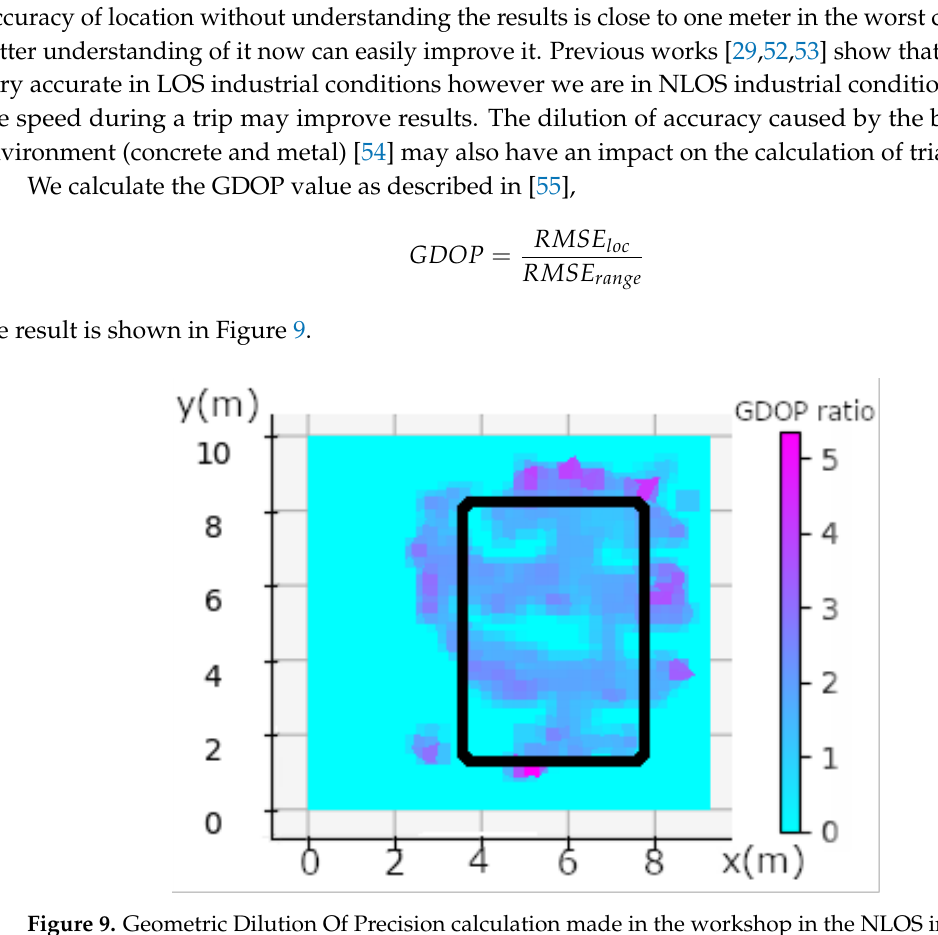
Figure 9. Geometric Dilution Of Precision calculation made in the workshop in the NLOS industrial condition. Black rectangles show the area where UWB anchors are placed, one of them in each